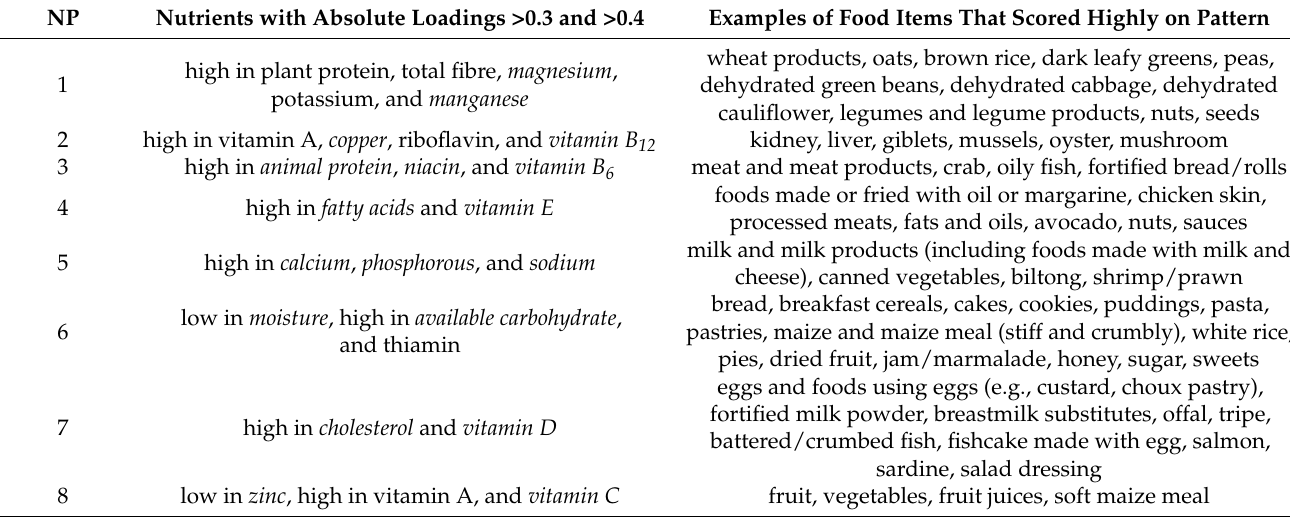
Table 3. Characterisation of nutrient patterns (NP).